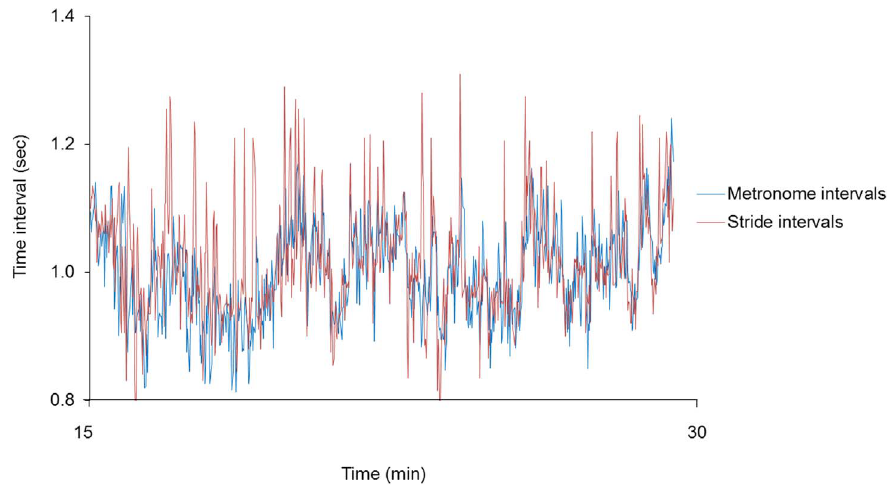
Figure 2. Synchronization phase time series for the metronome and stride intervals in Experiment 1. The fractal pattern of the metronome time series that prescribed the gait patterns is depicted in blue and the actual stride interval time series during the synchronization phase is depicted in red. Although the stride interval time series had greater variability magnitude, similar underlying structure is observed in both time series.